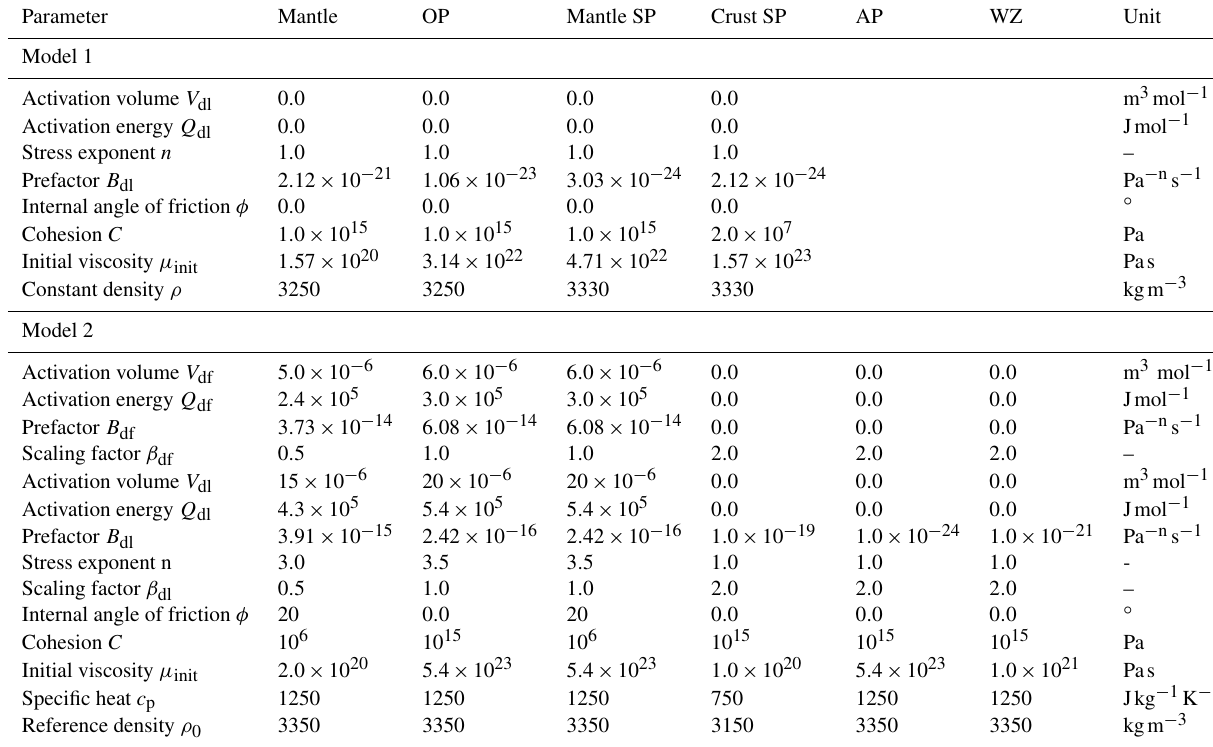
Stress exponent n Scaling factor β